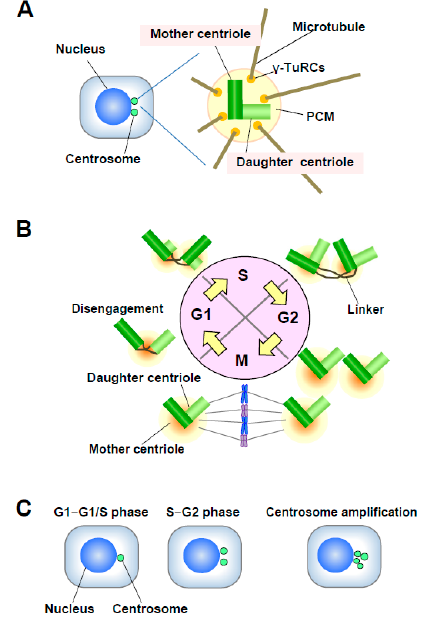
Figure 2. ( A ) Structure of the centrosome. The centrosome consists of a pair of centrioles, mother centriole and daughter centriole, embedded in the pericentriolar matrix (PCM). The PCM contains γ -TuRCs, which play roles in nucleating, anchoring, and positioning microtubules (MTs). ( B ) Centrosome duplication in the cell cycle. The mother and daughter centrioles are disengaged in late mitosis-early G1 phase. After centriole disengagement, a proteinaceous linker is established between the two centrioles and physically connects them. The building of the new centriole starts in the early S phase with the formation of a procentriole at each centriole. One new daughter centriole forms perpendicularly to each mother centriole during the S phase, and the new daughter centriole gradually elongates during the S and G2 phases. In late G2 phase, the two centrosomes separate through the dissolution of the linker and move to opposite sides of the cell to form the spindle poles. ( C ) Number of centrosomes. Normally, the centrosome number is one or two in interphase. Centrosome amplification is usually defined as more than two centrosomes per cell. BARD1 localizes to the centrosome and functions in centrosome duplication and the regulation of MT organizing activity of centrosomes together with BRCA1 [10–12]. We recently identified the BRCA1/BARD1-interacting proteins Obg-like ATPase 1 (OLA1) and receptor for activated C kinase (RACK1) [13,14]. In this review, we focus on the function of BARD1 in centrosome regulation and its role as a tumor suppressor together with BRCA1/OLA1/RACK1. In addition, we describe the tissue- specific effects of dysregulation of these processes on carcinogenesis in breast cancer.